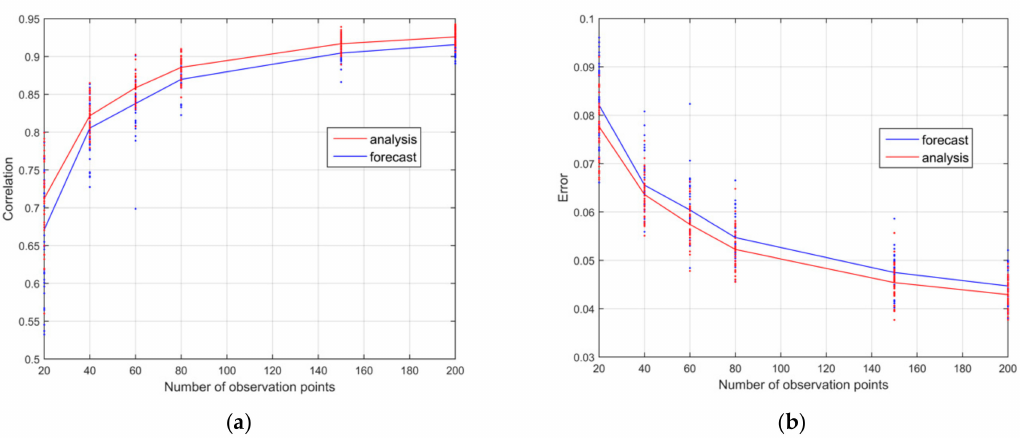
Figure 9. Correlation ( a ) and error ( b ) of the average point representing a di ff erent ensemble size (whose members are reported by single dots) of the analyses and the subsequent forecast obtained from datasets of velocity measures characterized by a di ff erent number of observation points randomly positioned: 20, 40, 60, 80, 150, and